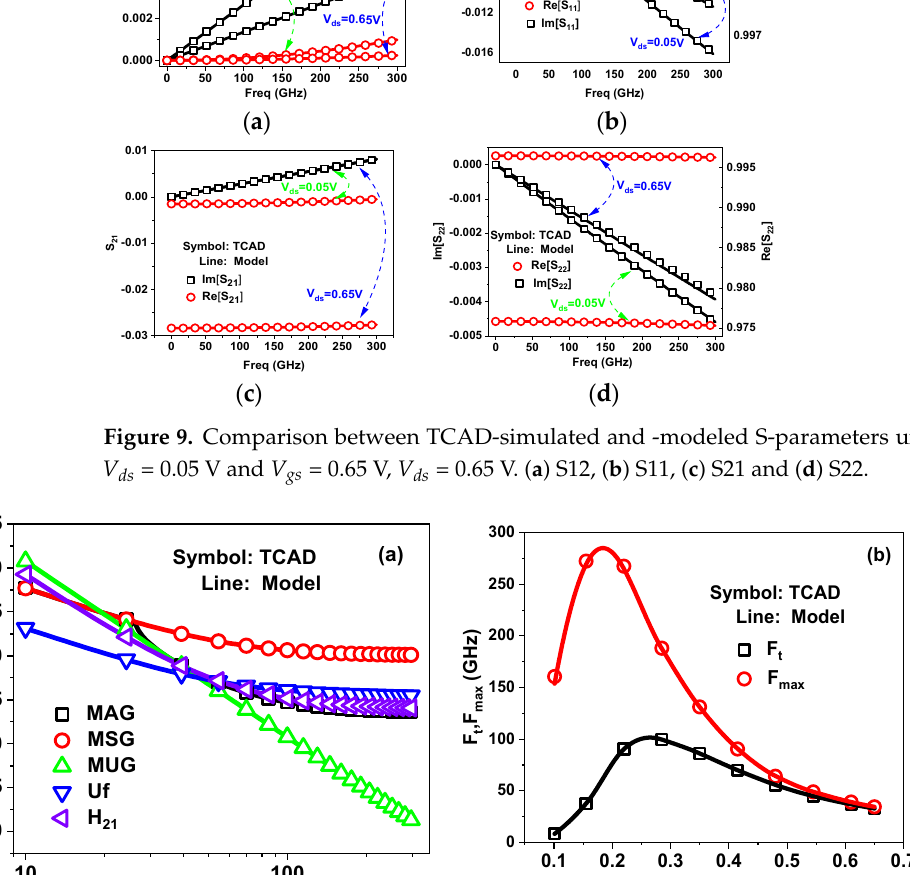
Figure 10. Comparison between simulated (symbols) and modeled (solid lines) ( a ) MAG , MSG , MUG , Uf and H 21 under V gs = 0.65 V, V ds = 0.65 V. ( b ) F t and F max as a function of Vgs under Vds = 0.05 V.